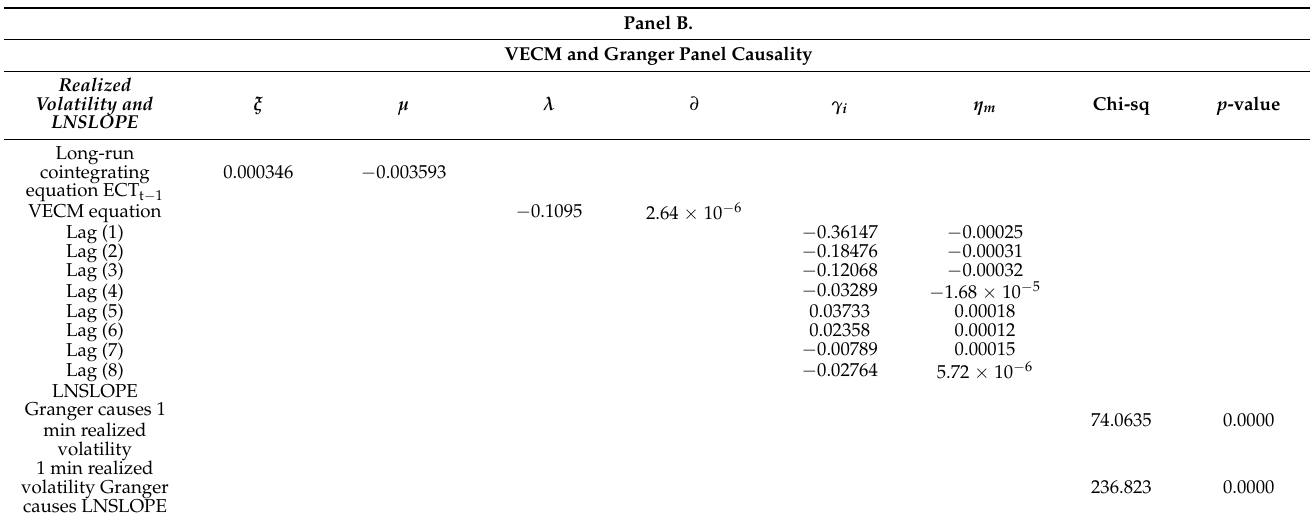
Panel B. VECM and Granger Panel